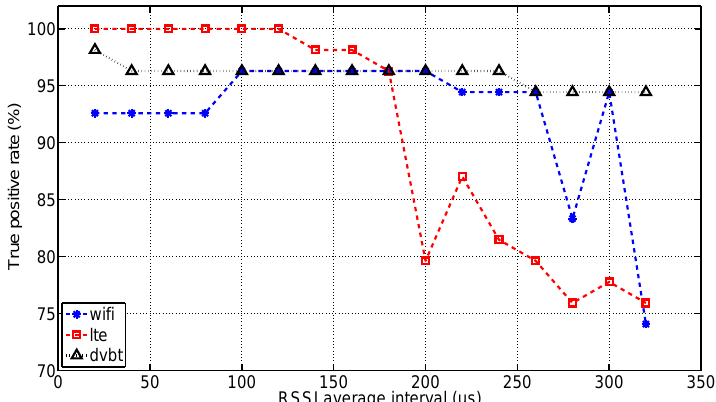
Figure 11. The true positive rate versus the average interval of RSSI measurements for T = 1 s. Because the IQ samples are acquired at 1 MHz, the interval N size N in µ